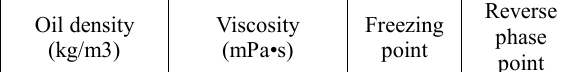
Table 1. Crude oil properties in the Luliang oil